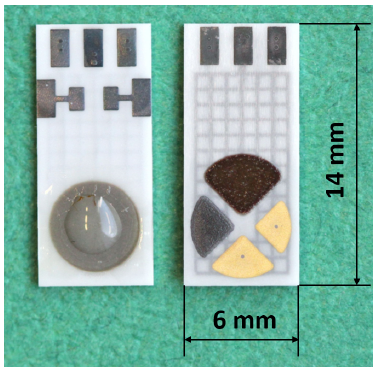
Figure 6. Separated HTCC-based sensor array variant 1/ Bottom left: reference electrode; top right: pH electrode, Cu 2 + ISE, and two other ISEs like Ca 2 + , K + , or NH +